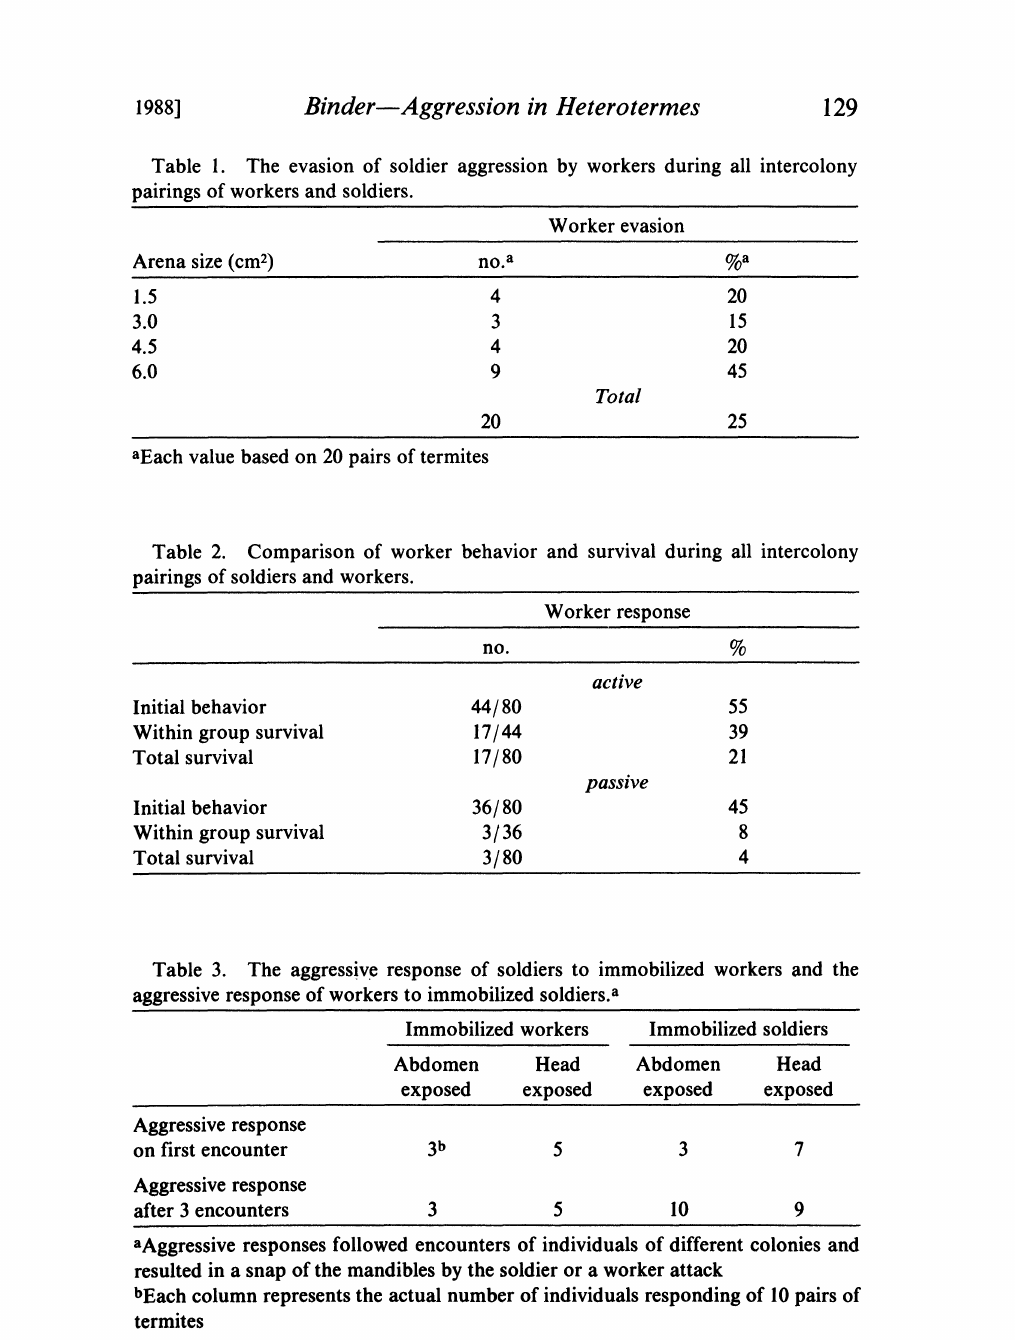
Table 3. The aggressive response of soldiers to immobilized workers and the aggressive response of workers to immobilized